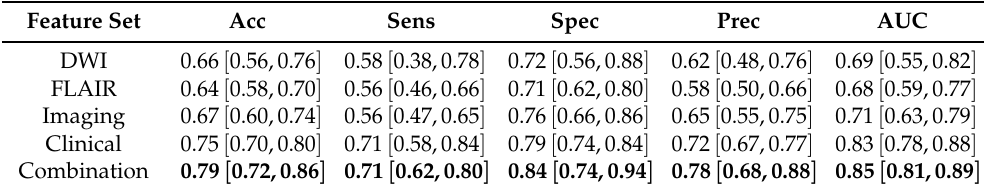
Table 1. Average metrics (95% CI) computed on the test sets for all the tested feature sets ( DWI set : only DWI radiomic features, FLAIR set : only T2-FLAIR radiomic features, imaging set : both DWI and T2-FLAIR radiomic features, clinical set : only clinical characteristics, combination set : combination of all the radiomic features and the clinical characteristics). For each feature set, Accuracy (Acc), Sensitivity (Sens), Specificity (Spec), Precision (Prec), and Area under the ROC curve (AUC) are reported.